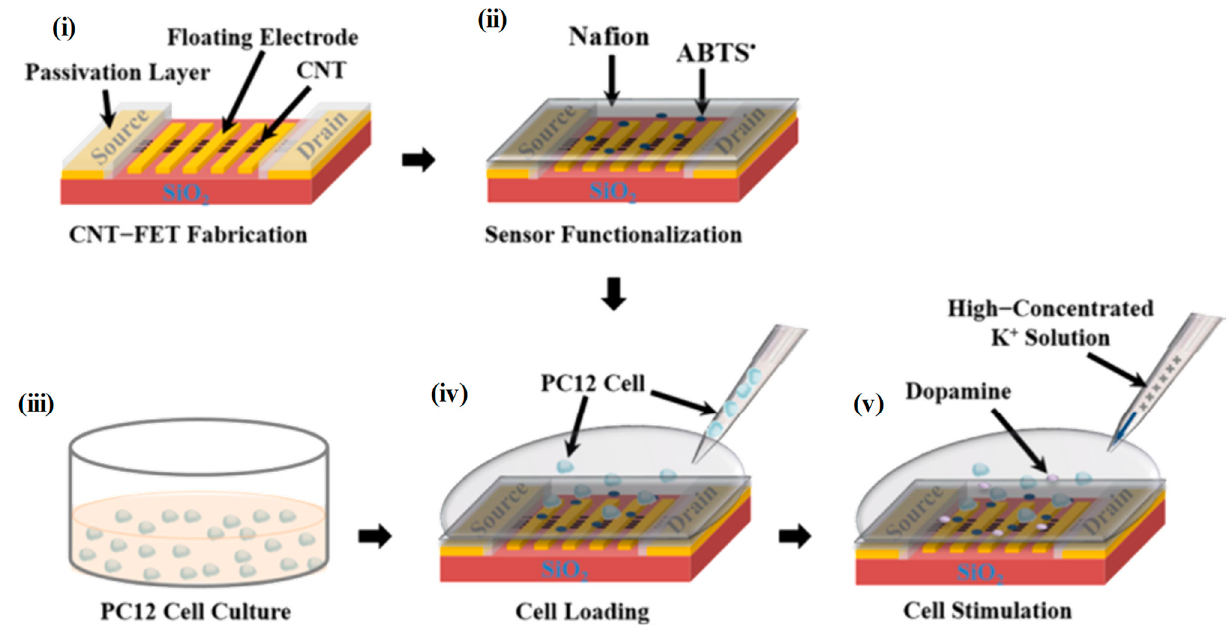
Figure 5. Schematic diagram depicting preparatory processes for the detection of dopamine by using an NRC sensor: ( i ) Fabrication of a conventional CNT-FET device with floating electrodes; ( ii ) functionalization of the device by a Nafion-radical hybrid film to build an NRC sensor; ( iii ) culturing of PC12 cells in RPMI 1640 medium; ( iv ) transferring of the cells into the sensor surface; ( v ) stimulating of the cells by a high concentrated K+ solution and measuring of dopamine release by using the sensor. Reprint with permission from [103]. Copyright (2019) American Chemical Society.